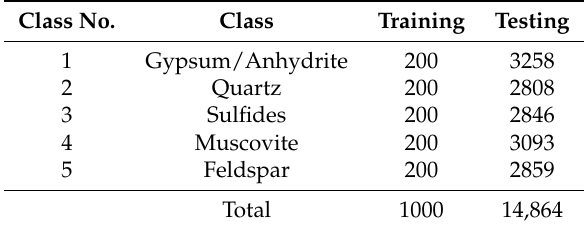
Table 2. The numbers of training and test samples used for the classification purpose on the TS4 dataset. Class